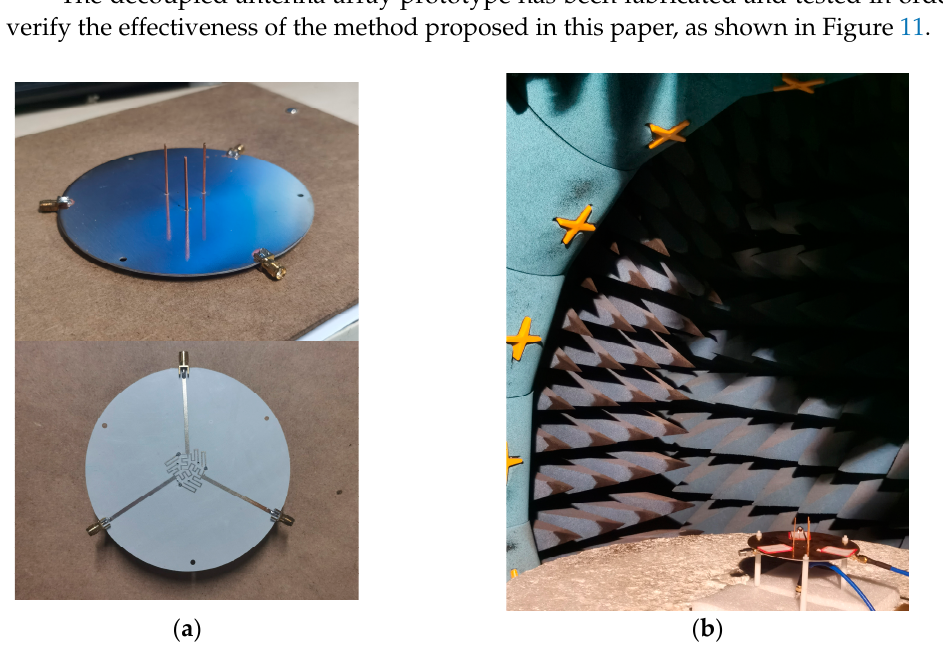
Figure 11. ( a ) Fabricated prototype; and ( b ) measurement in chamber.